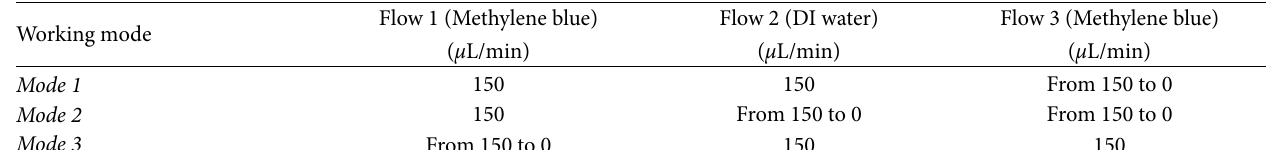
Figure 5: The experimental setup of multi-controlled valve connecting to microfluidic system and micro-syringe pumps. Table 1: Data of operation modes in mixing process experiments.